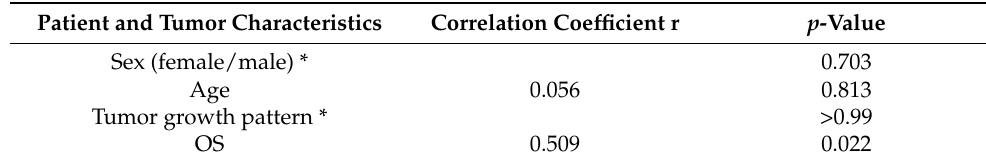
Table 4. Correlation and distribution of PCDHGC3 mRNA expression within glioma grade 2/3 patients and tumor characteristics.